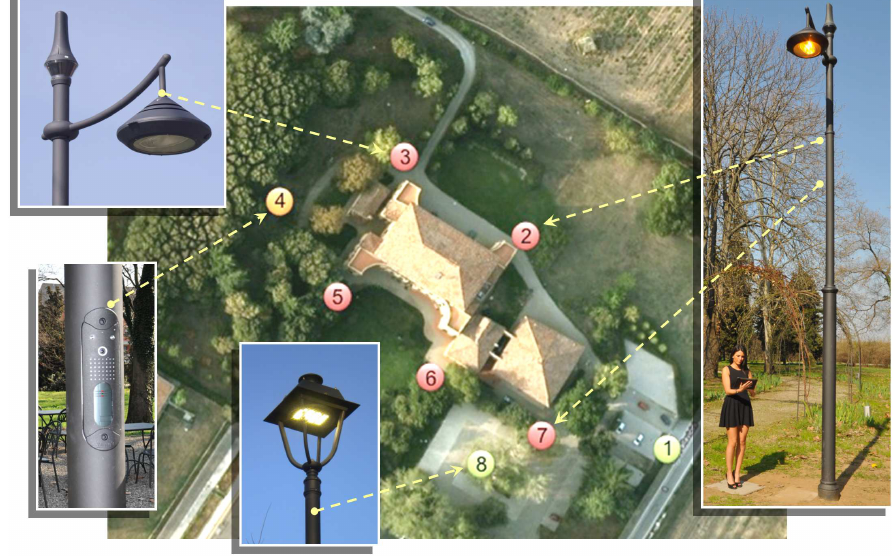
Figure 2. Smart city testbed at Fondazione Alma Mater